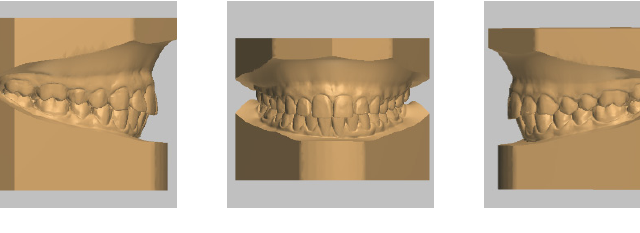
Figure 13. Post-treatment digital model.